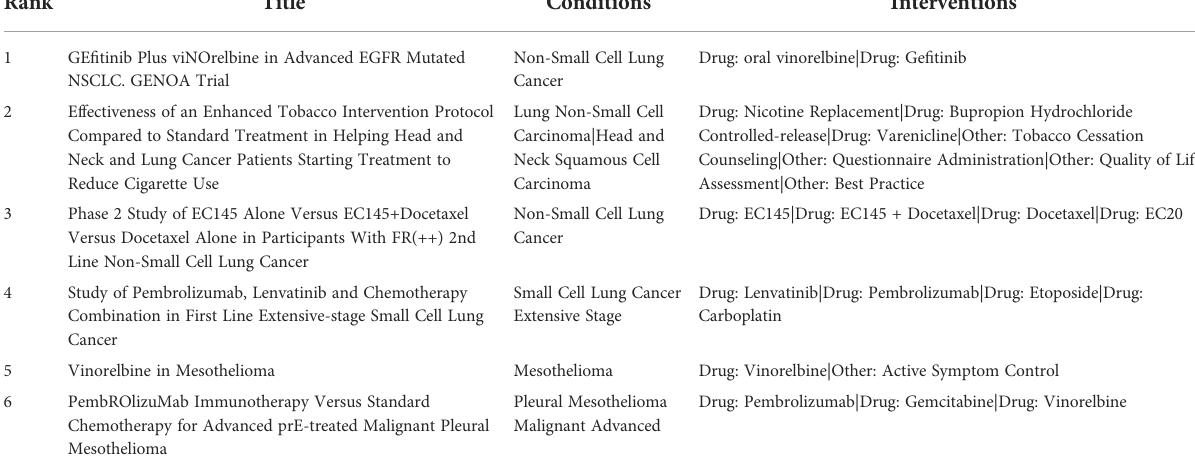
TABLE 3 Summary of clinical trials on alkaloid based formulation for lung cancer. Rank Title Conditions Interventions 1 GE fi tinib Plus viNOrelbine in Advanced EGFR Mutated NSCLC. GENOA Trial 2 Lung Non-Small Cell